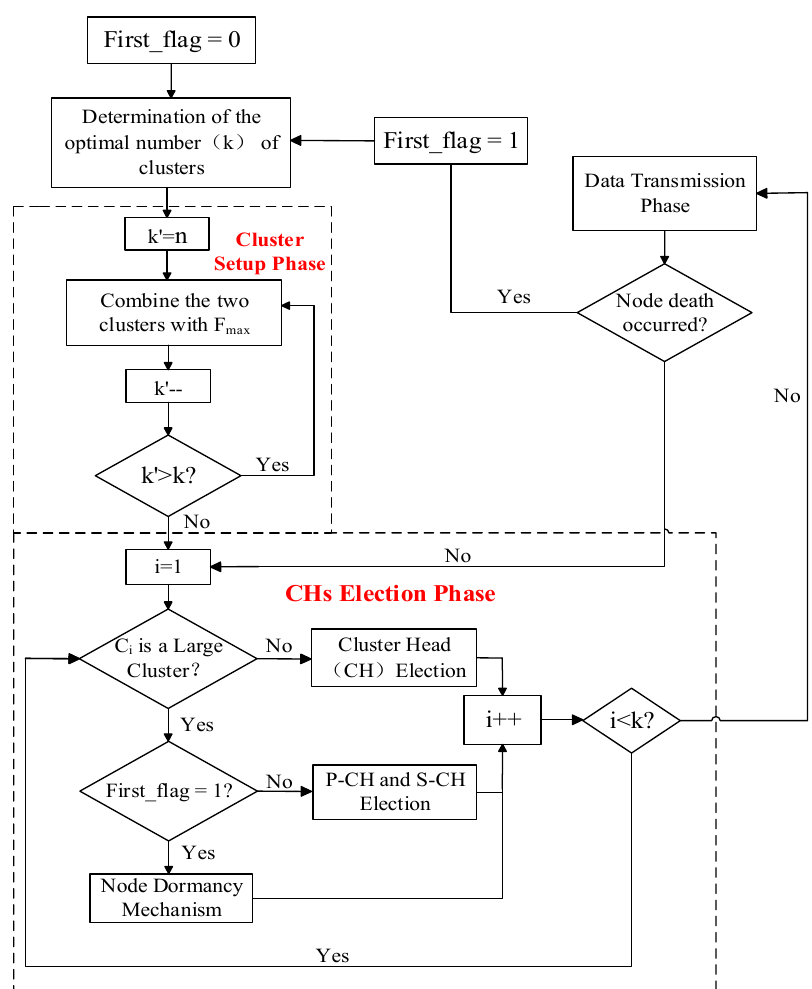
Figure 4. The time slot allocation of the clustering protocol.